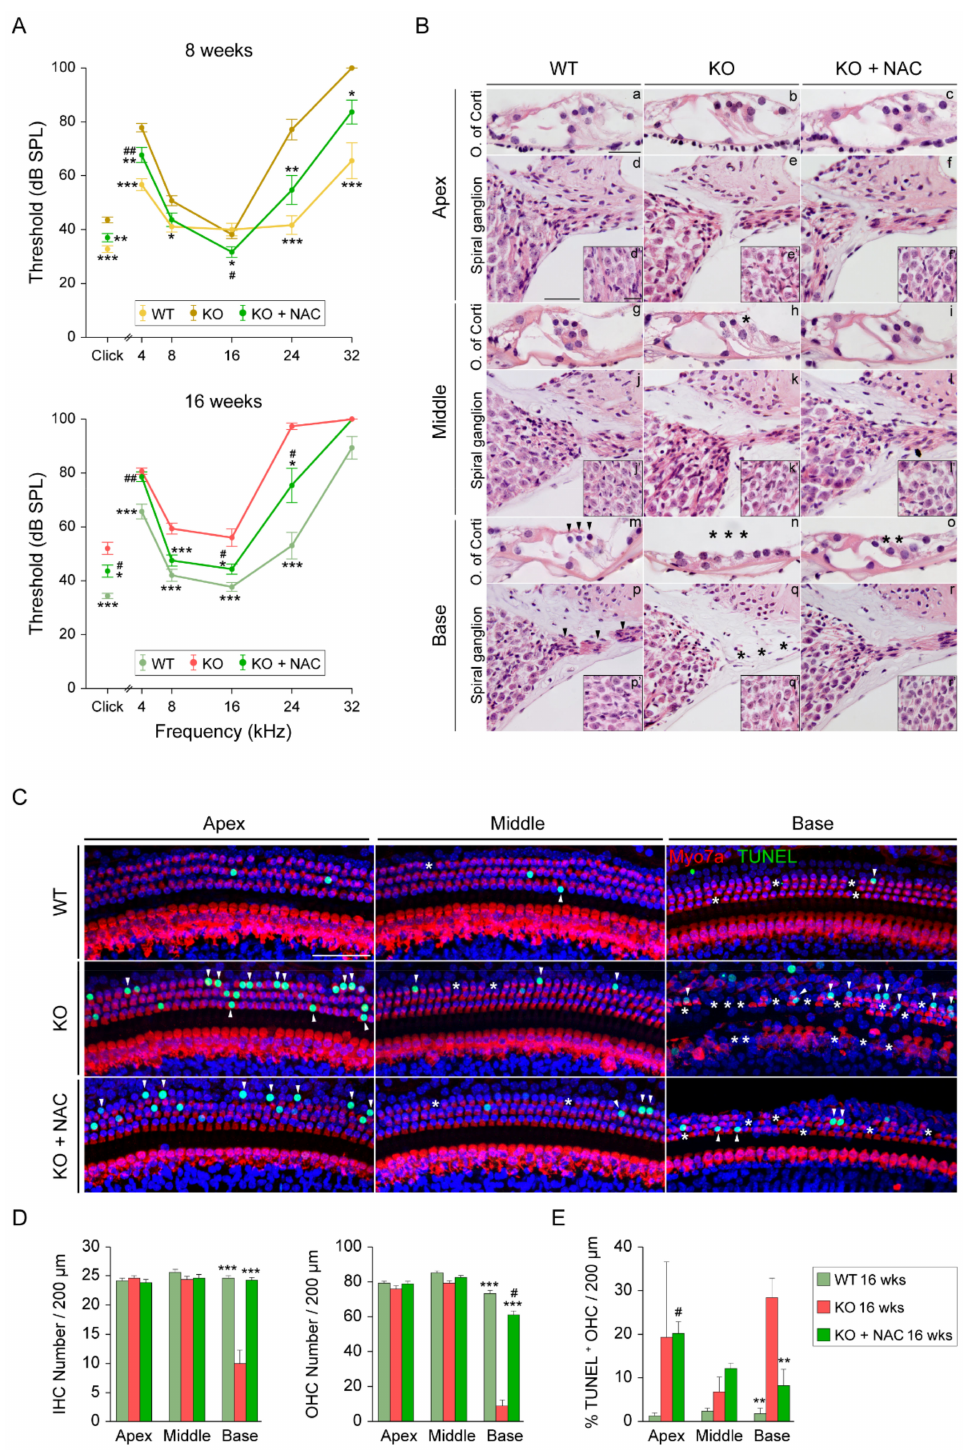
Figure 3. Comparative hearing evaluation, cochlear cytoarchitecture and organ of Corti degeneration. ( A ) Audiograms representing click and tone burst stimuli (4, 8, 16, 24 and 32 kHz) auditory brainstem response (ABR) thresholds of 8-